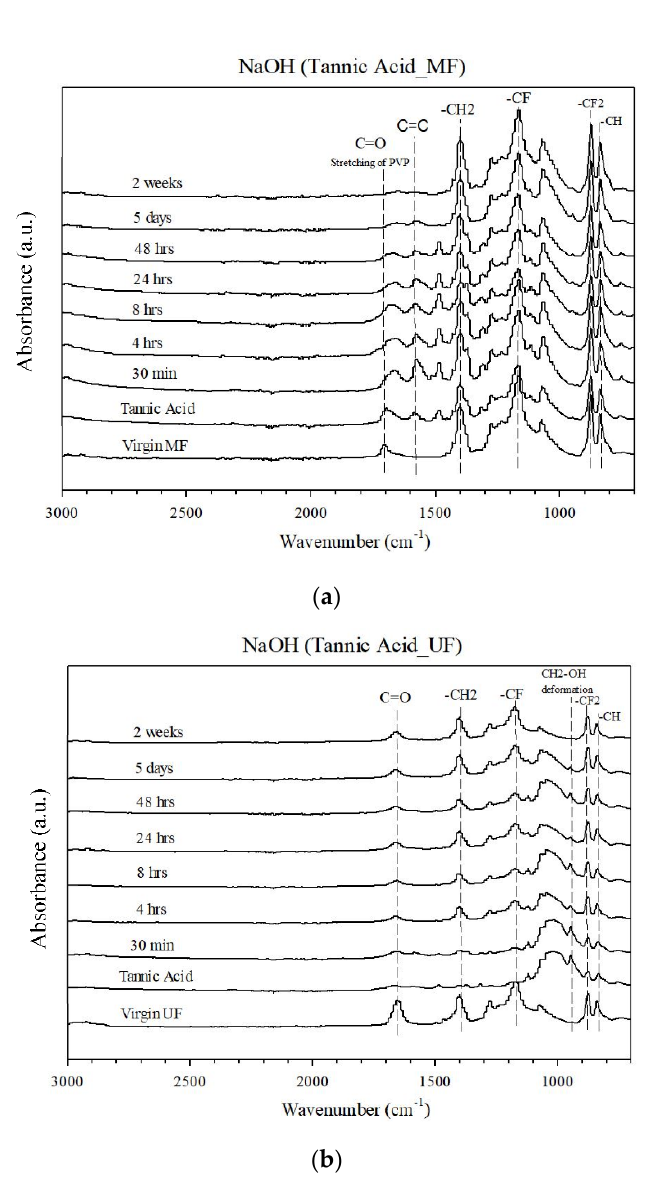
Figure 5. FTIR spectra of virgin and fouled ( a ) MF and ( b ) UF membranes filtrated with the tannic acid solution after soaking in NaOH at different periods from 30 min to 2 weeks. Table 2. Tensile strength, modulus of elasticity, and elongation of virgin and NaOH-cleaned MF